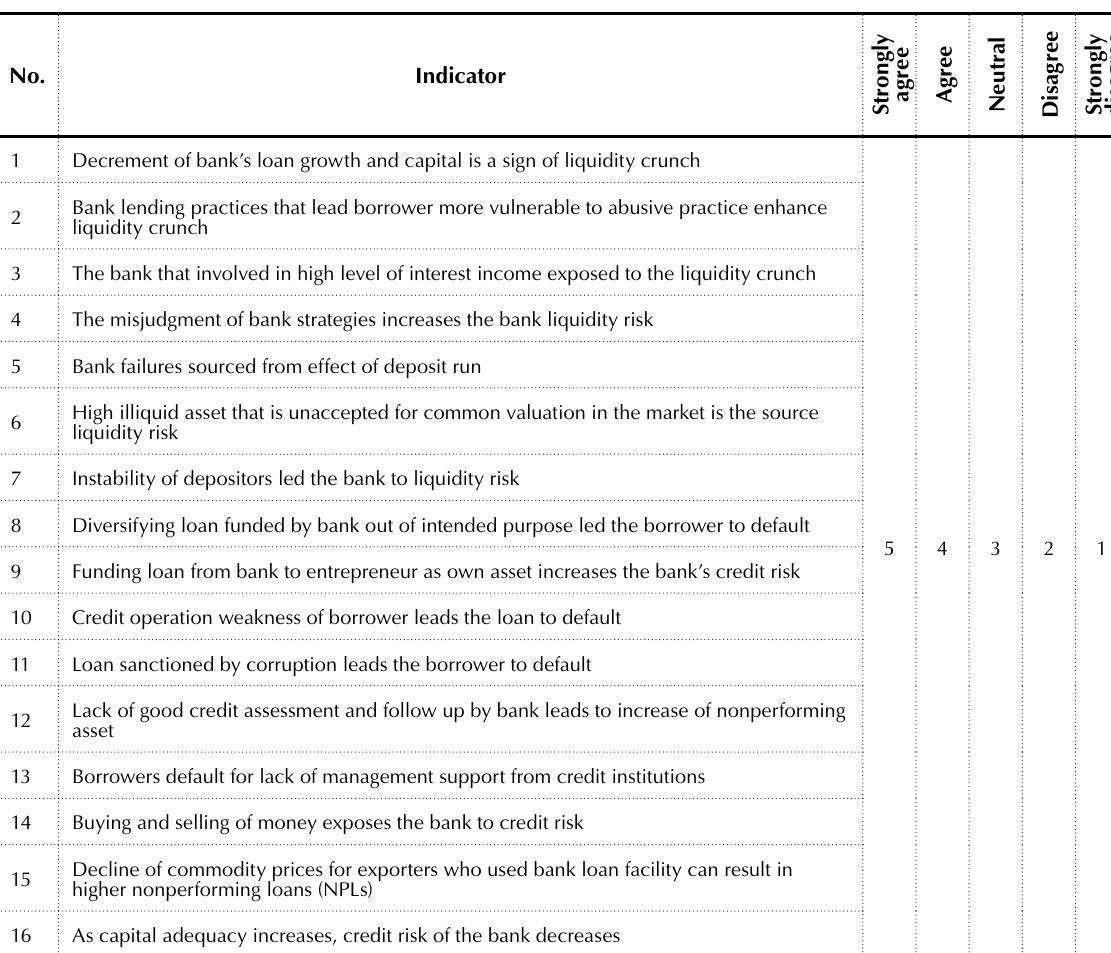
Table 1. Indicators of credit risk and liquidity crunch measures